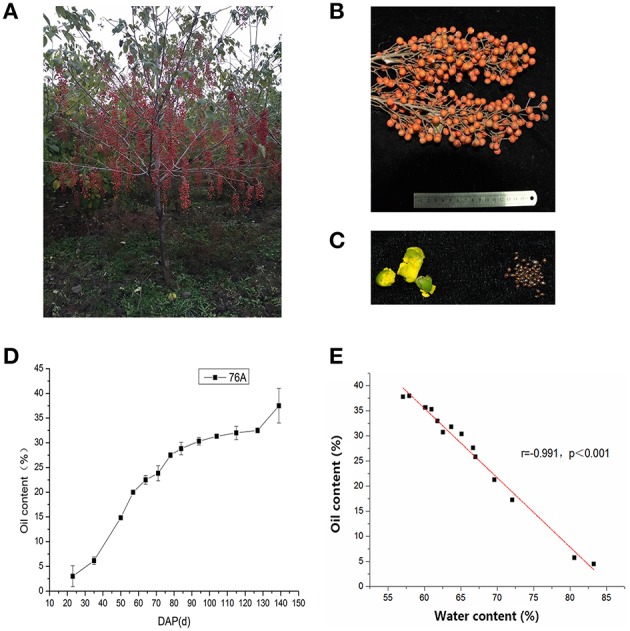
Oil accumulation in I. polycarpa line 76A. (A) View of the line 76A at harvest time. (B) Close view of the 76A fruits. (C) Separated seed and pericarp tissues from 76A fruits at 65 DAP (days post pollination). (D) Mean percentage of oil content (% dry weight) at different times during fruit development. Each point in the graphs represents the mean of three replicates ± SD. (E) Negative correlation of fruit oil content and water content.